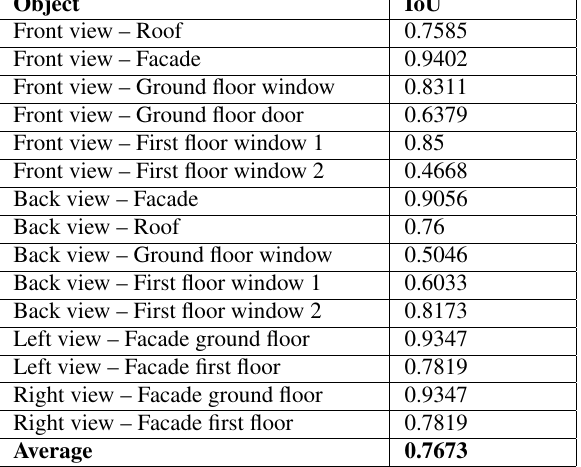
Table 4. IoU results for BAG ID 0164100000294714